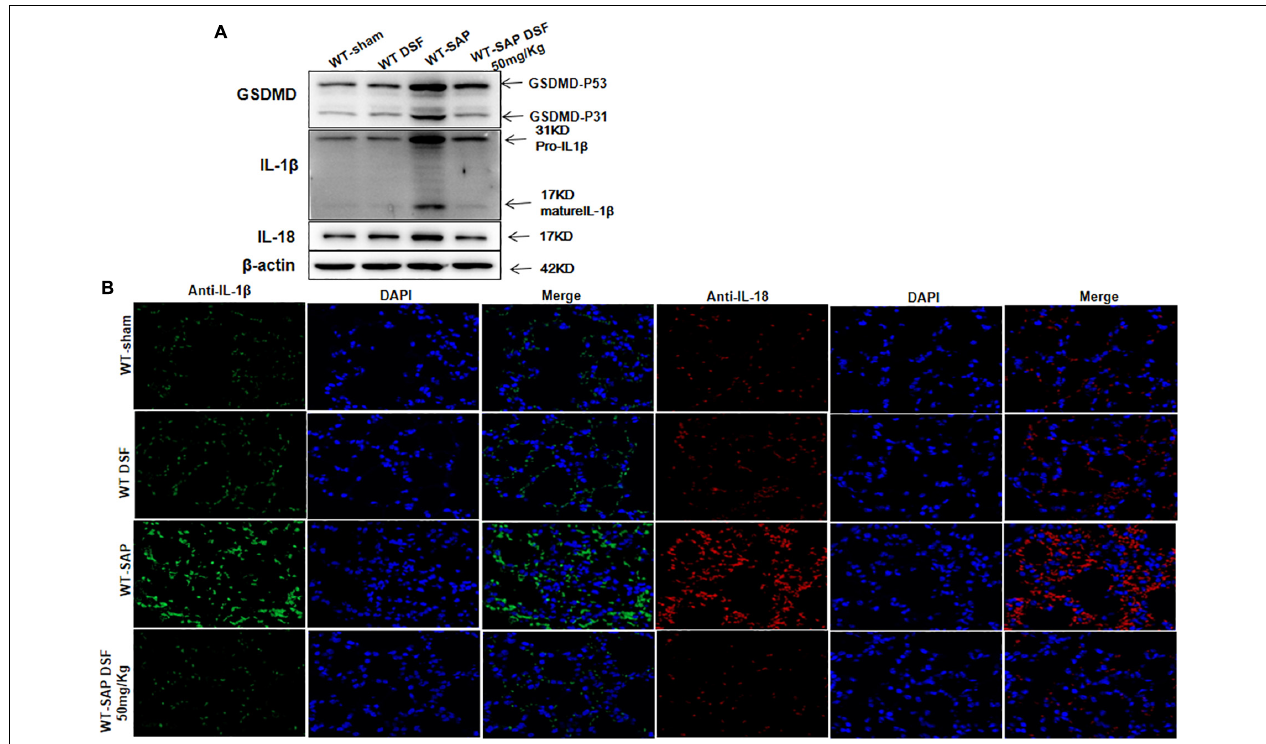
FIGURE 6 | DSF inhibits the cleavage of GSDMD and decreases the levels of IL-1 β and IL-18 in lung tissues. WT-sham and WT-SAP mouse models were treated with DSF (50 mg/kg). The mice were sacrificed 24 h after LPS injection. (A) Western blotting analysis of GSDMD, IL-1 β , and IL-18 in the lung. Scale bars, × 200. Experiments were repeated three times. (B) Immunofluorescence labeling of IL-1 β (green), IL-18 (red), and DAPI (blue) in the four WT groups, Scale bar, × 200. Data are presented as mean ± SD ( n = 10 per group). DSF, disulfiram; GSDMD, gasdermin D; WT, wild type; SAP, severe acute pancreatitis; LPS,